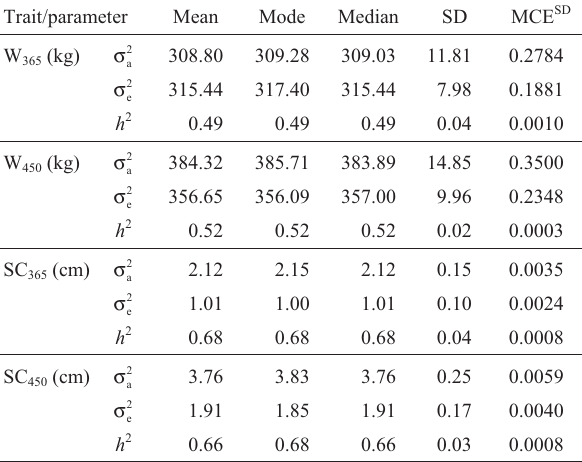
Table 2 - Descriptive statistics for variance components and heritabilities estimates for weight at 365 (W 365 ) and 450 (W 450 ) and scrotal circumfer- ence at 365 (SC 365 ) and 450 (SC 450 ) days of age, obtained from single-trait analyses using Gibbs sampling.